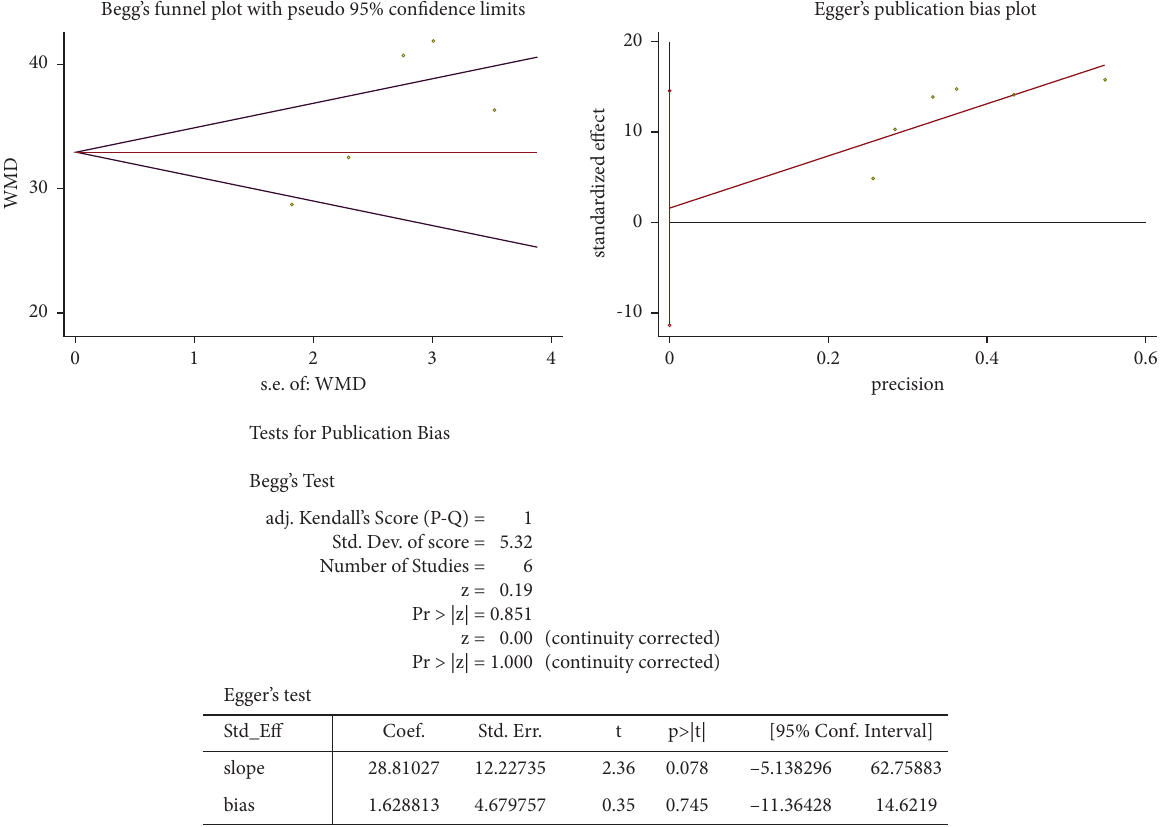
Figure 6: Publication bias analysis by Begg’s and Egger’s tests regarding the combined anterior-posterior